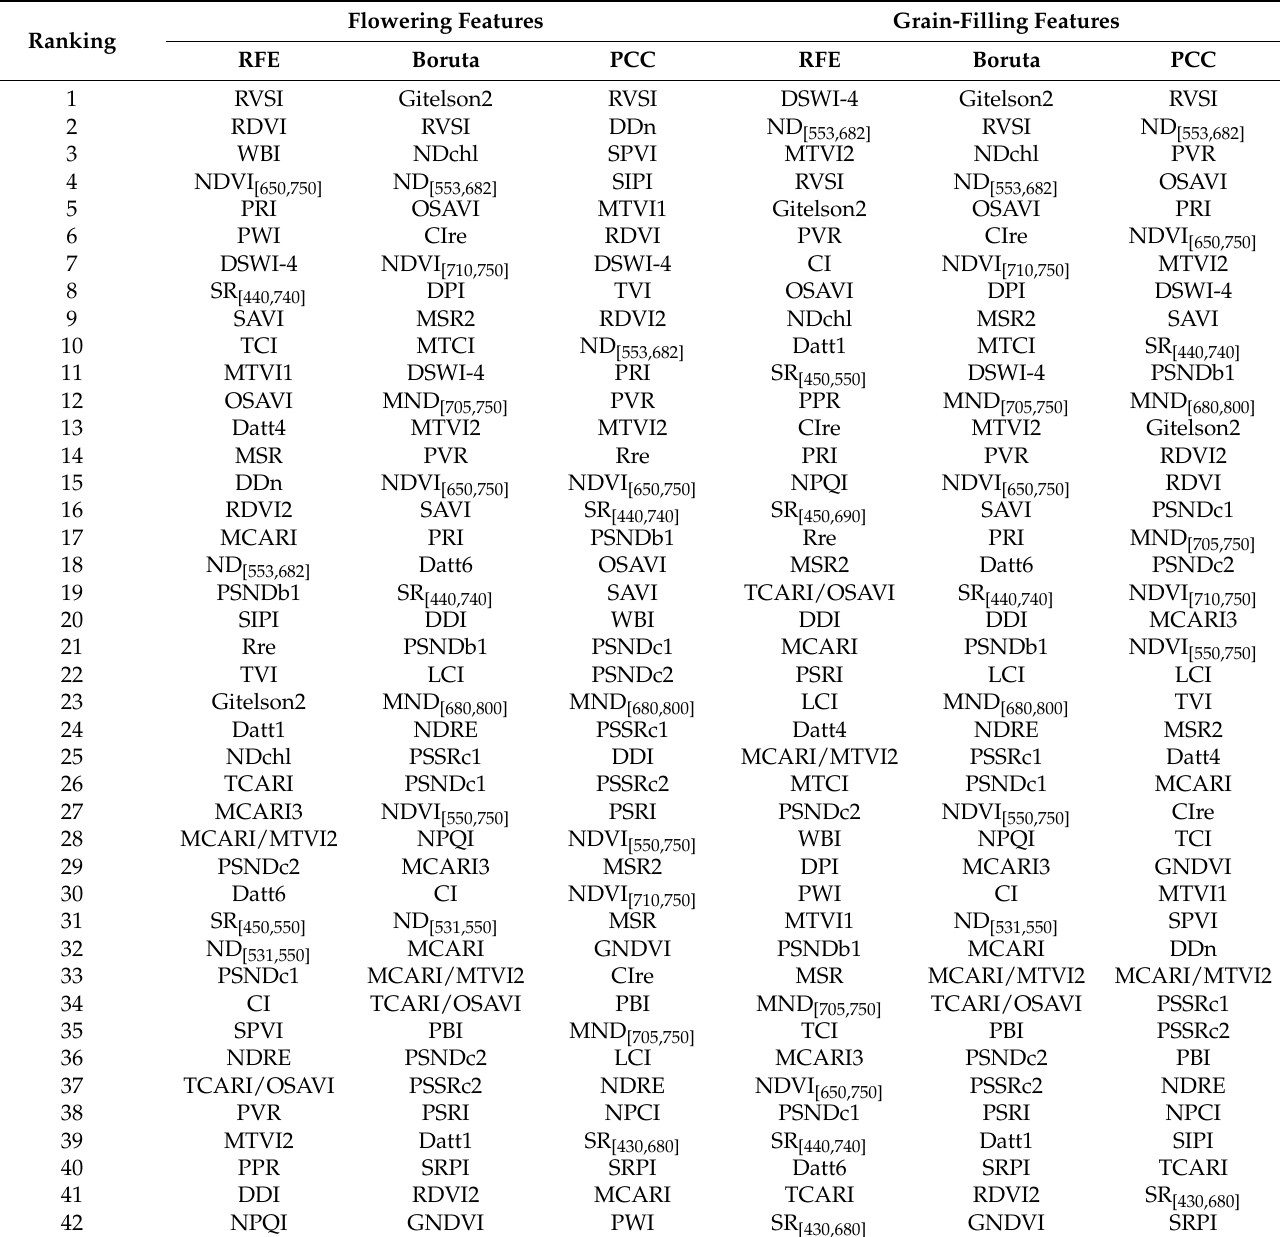
Table A2. Ranking of all 60 features for the three feature selection methods at the flowering and grain-filling stages of winter